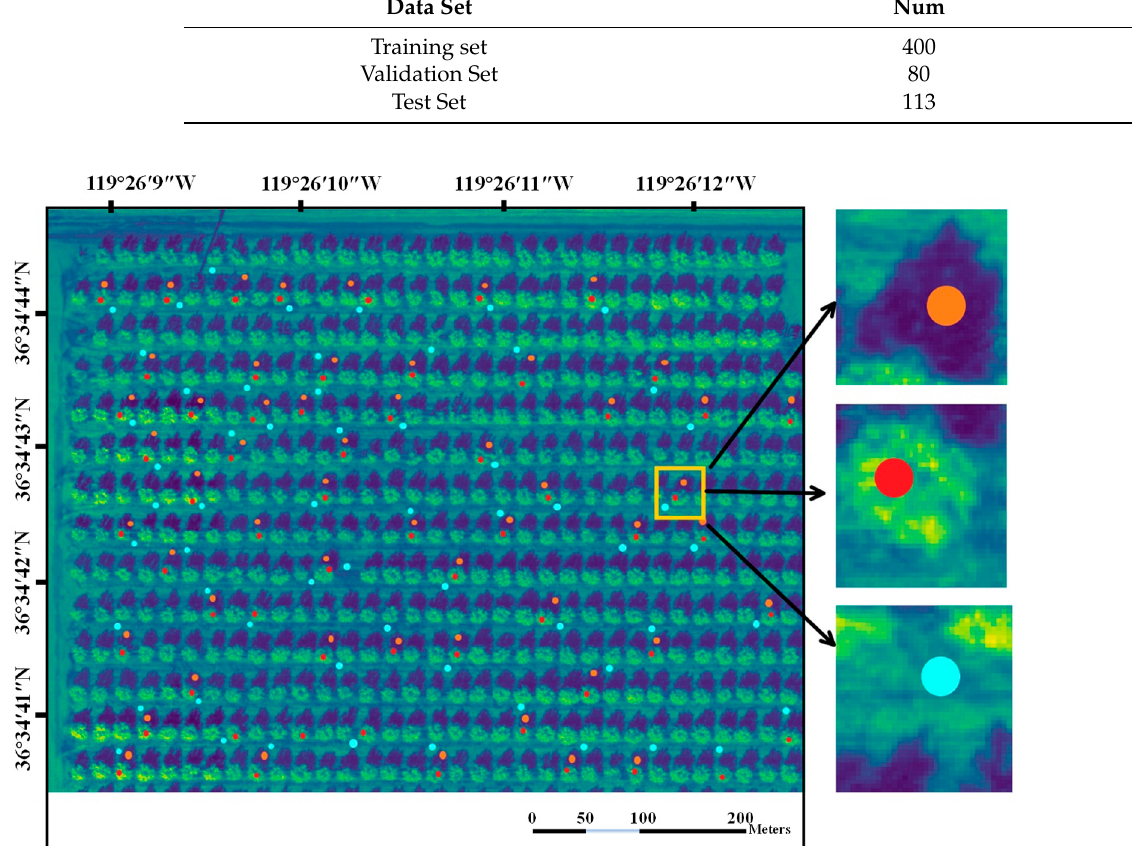
Figure 3. Randomly selected points for reflectance sampling. Red circles indicate trees, orange circles indicate tree shadows, and cyan circles indicate soil.